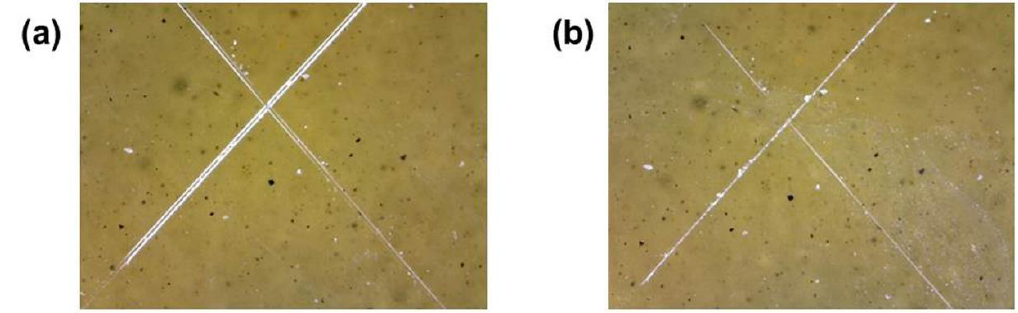
Figure 6. OM images ( a ) before and ( b ) after healing of FEEMA64_mGO0.030 wt%.